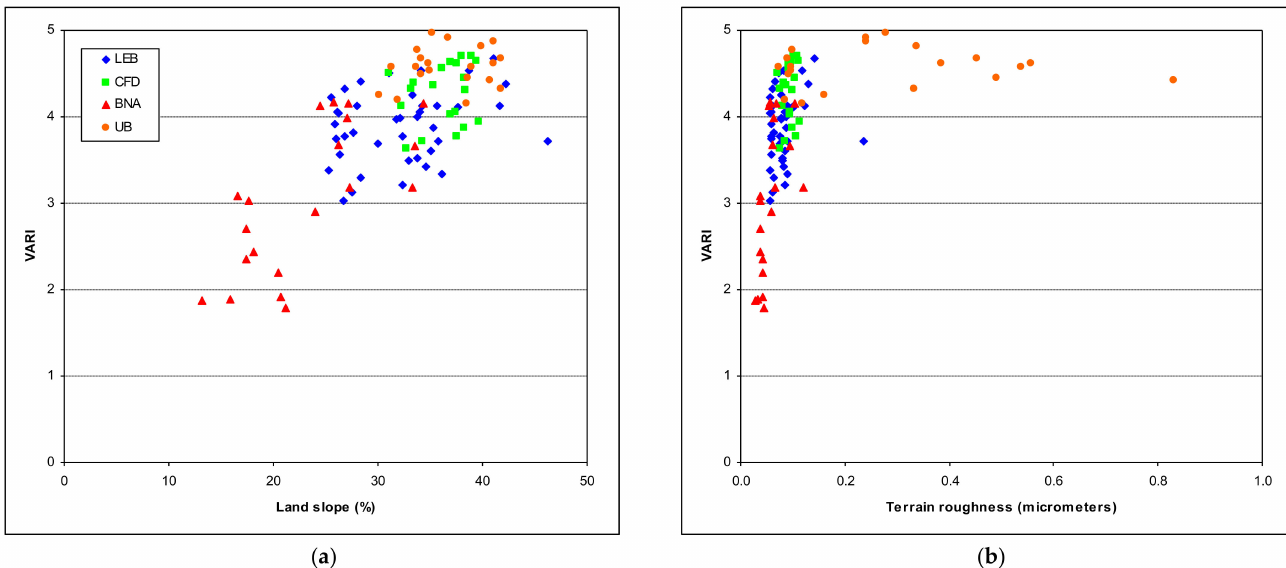
Figure 10. Scatterplots of vegetation regeneration (measured by VARI by UAV images of 2016) versus land slope ( a ) and terrain roughness ( b ) among four land conditions after the wildfire of 2012 in Sierra de Los Donceles forest (Castilla-La Mancha,